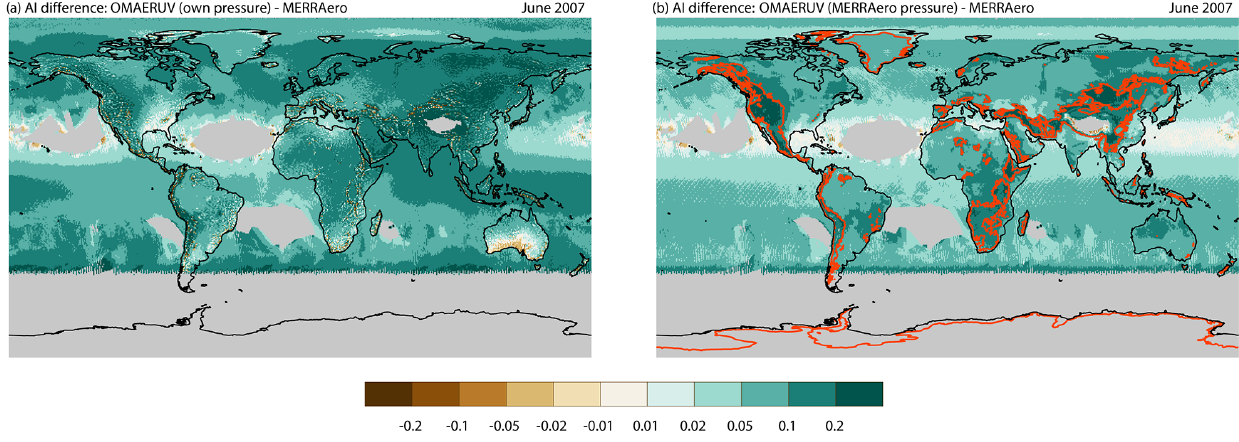
Figure 3. OMAERUV–MERRAero AI differences for June 2007. (a) OMAERUV AI calculated using its own surface pressure. (b) OMAERUV AI calculated using MERRAero surface pressure. The red line is the 1000m topographic height contour.